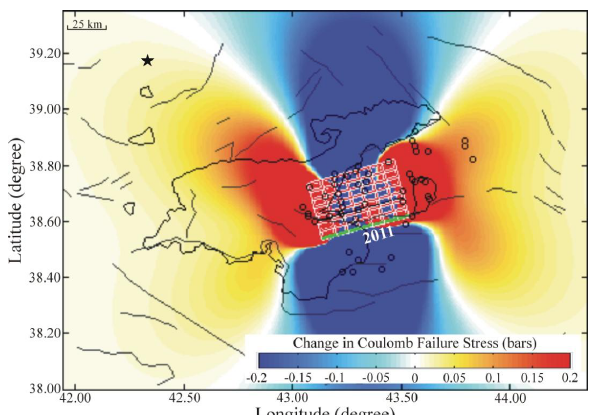
Fig. 7. Coulomb stress changes imparted to the hypocentral area of the 26 March 2012 aftershock ( M w = 5.0; number 50 in Ta- ble 3 and is indicated with a black star) due to the 2011 Van earth- quake rupture. The stress calculations have been implemented over its north dipping nodal plane (strike = 256 ◦ , dip = 46 ◦ , rake = 86 ◦ ) . The open circles denote the epicentres of the M ≥ 4.6 aftershocks listed in Table 3. Notice occurrence of this far away aftershock in the stress enhancement area. See caption of Fig. 2 for the active fault